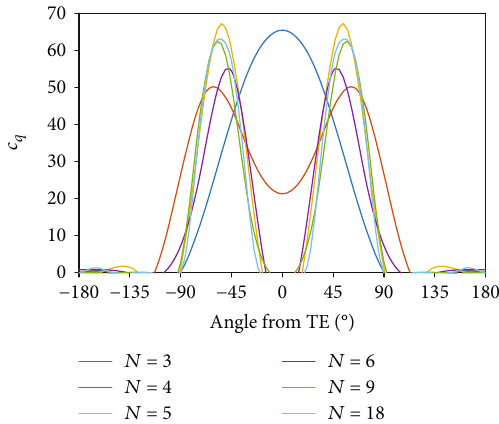
Figure 9: Suction pro fi les generated by optimisation with a varying number of control segments, N . The Nelder-Mead method result for N = 4 is used